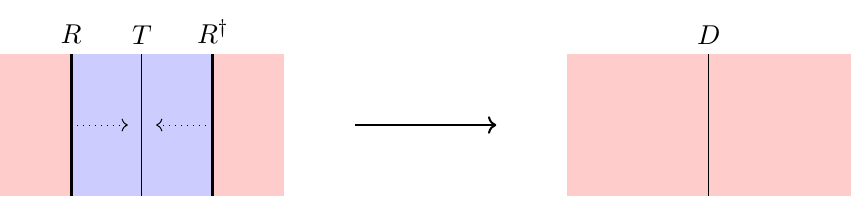
Figure 1 . Flow of a UV topological defect T under a bulk perturbation, for a case where this leads to an IR defect D . The flow is modeled as a fusion product of an RG defect R and its conjugate R † with T